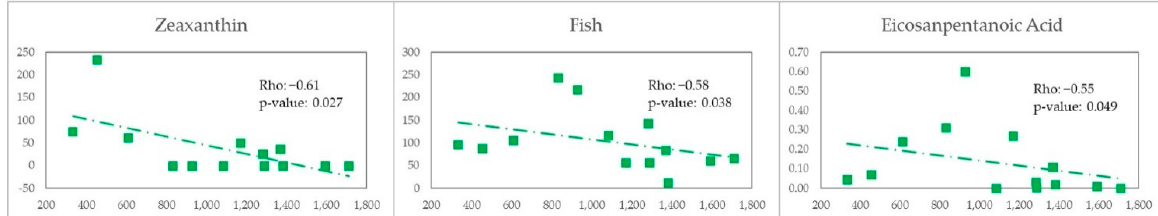
Figure 8. Scatter plot X—Erysipelotrichaceae, Y—Nutrients/Food for all MSM.